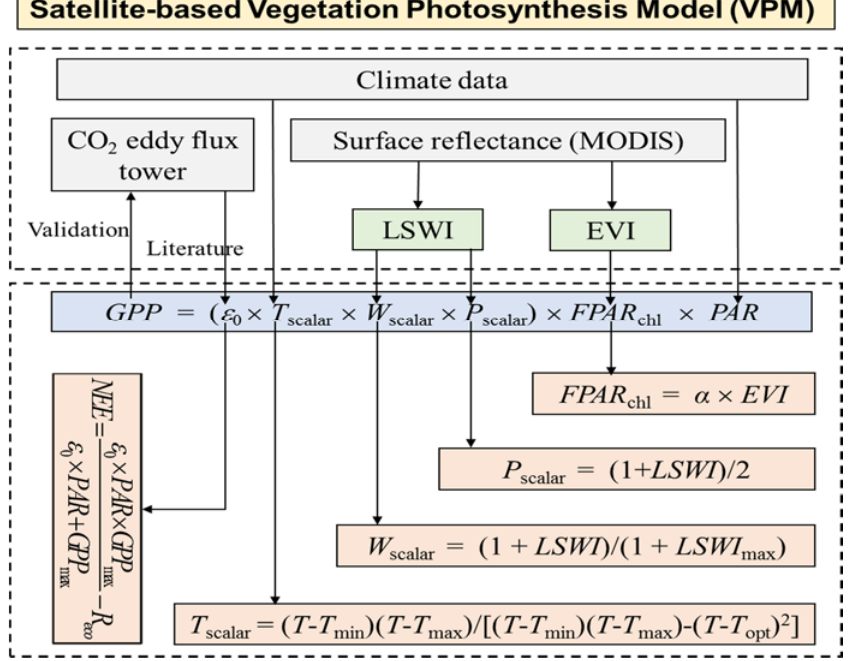
Figure 2. Structure of the vegetation photosynthesis model (VPM) model. CO 2 flux and climate data (air temperature, PAR, precipitation, etc.) come from the eddy flux tower. Vegetation indices (VIs) were extracted from the Moderate Resolution Imaging Spectroradiometer (MODIS) datasets. ε 0 , maximum light use efficiency; T scalar , W scalar , P scalar , the scalars for the effects of temperature, water and leaf phenology on light use efficiency of vegetation, respectively; FPAR chl , the fraction of PAR absorbed by leaf chlorophyll; PAR, the photosynthetically active radiation; LSWI max , the maximum Land Surface Water Index (LSWI); T max , T min , and T opt , the maximum, minimum, and optimal air temperature,